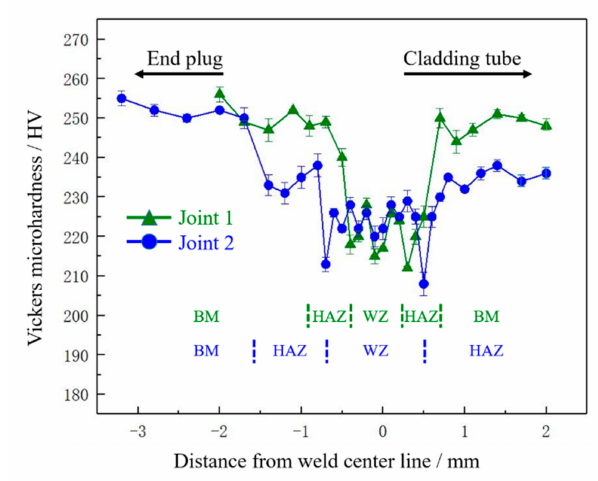
Figure 10. The average microhardness distributions in the cross-sections of joint 1 and 2, produced under 250 J / cm and 3600 J / cm,